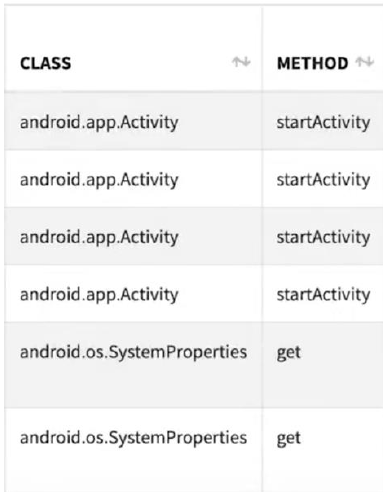
Figure 3. Example of API call sequences extracted using MobSF Tool.